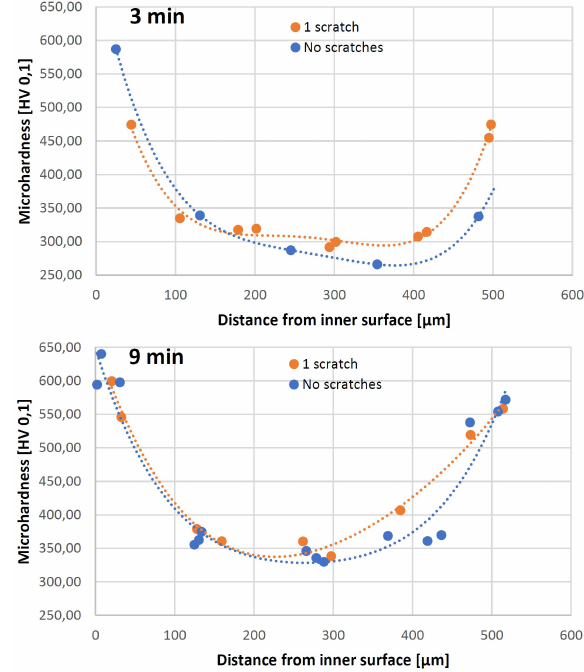
Figure 13. Transversely measured microhardness: 3 min exposition (top) and 9 min exposition